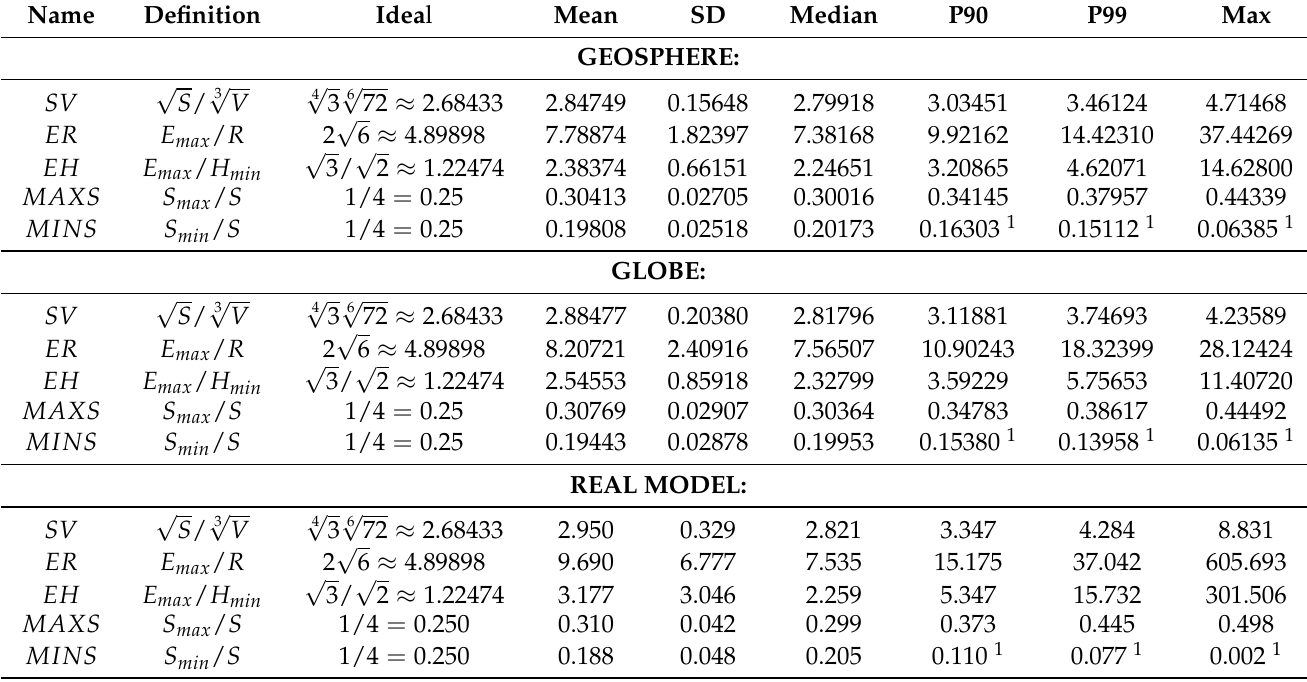
Table 8. Mesh quality measures of all the